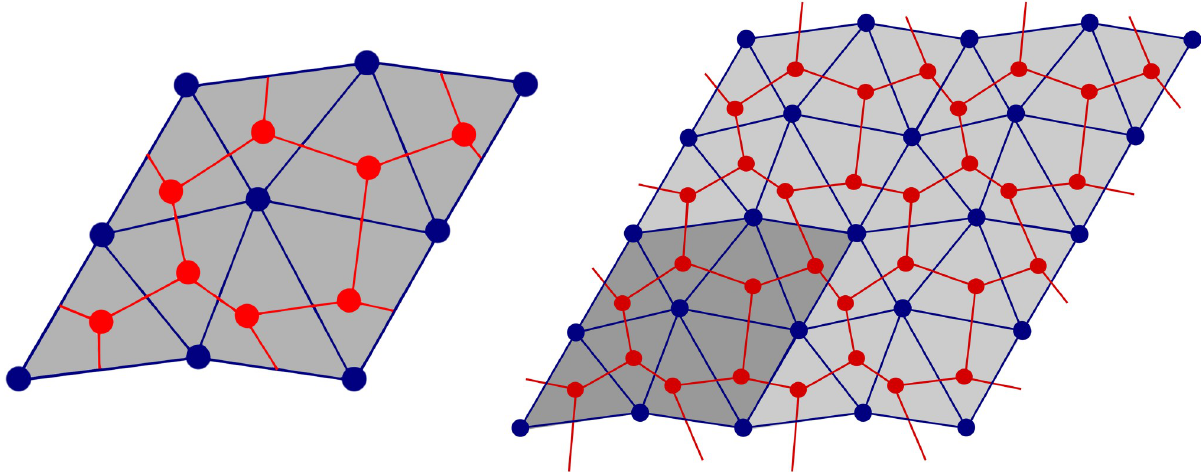
Fig 10. Towards realistic lobular structures. Left: The aggregate of 4 LRPC consisting of two portal lobules enables to create a larger periodic unit (the dark gray area), to consider nonuniform perturbations of the regular periodic structure which can comprise hexagonal and pentagonal hepatic lobulae